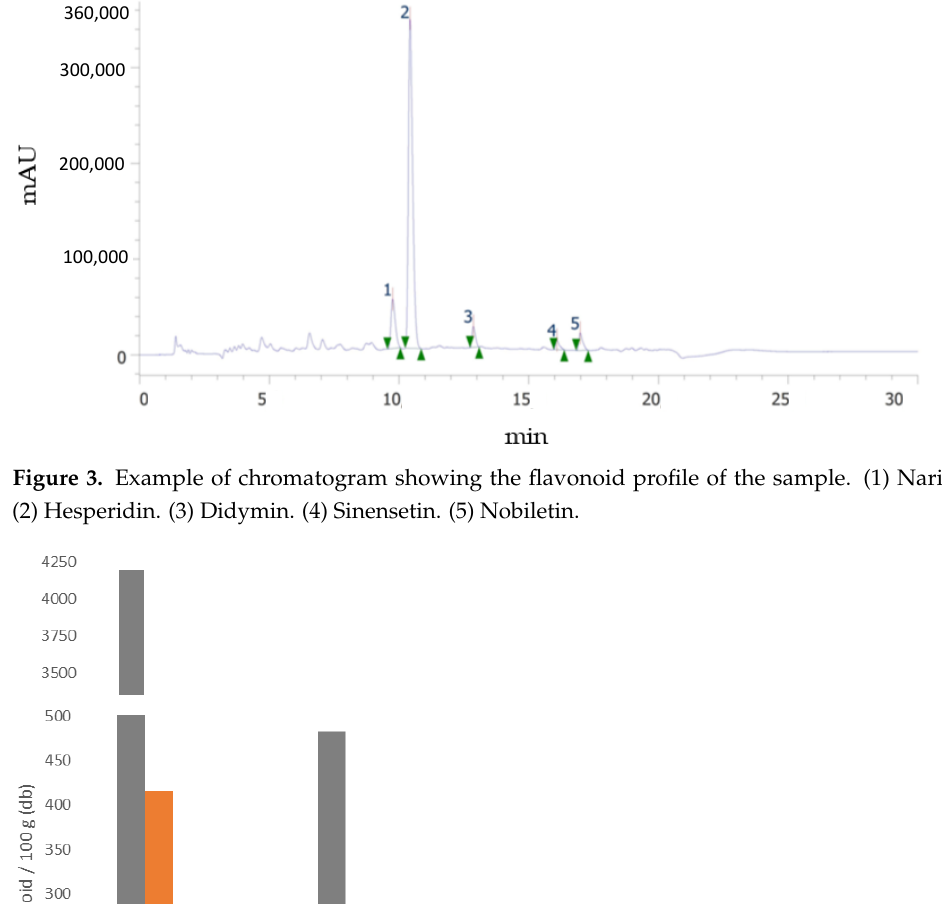
Figure 3. Example of chromatogram showing the flavonoid profile of the sample. (1) Narirutin. (2) Hesperidin. (3) Didymin. (4) Sinensetin. (5) Nobiletin.